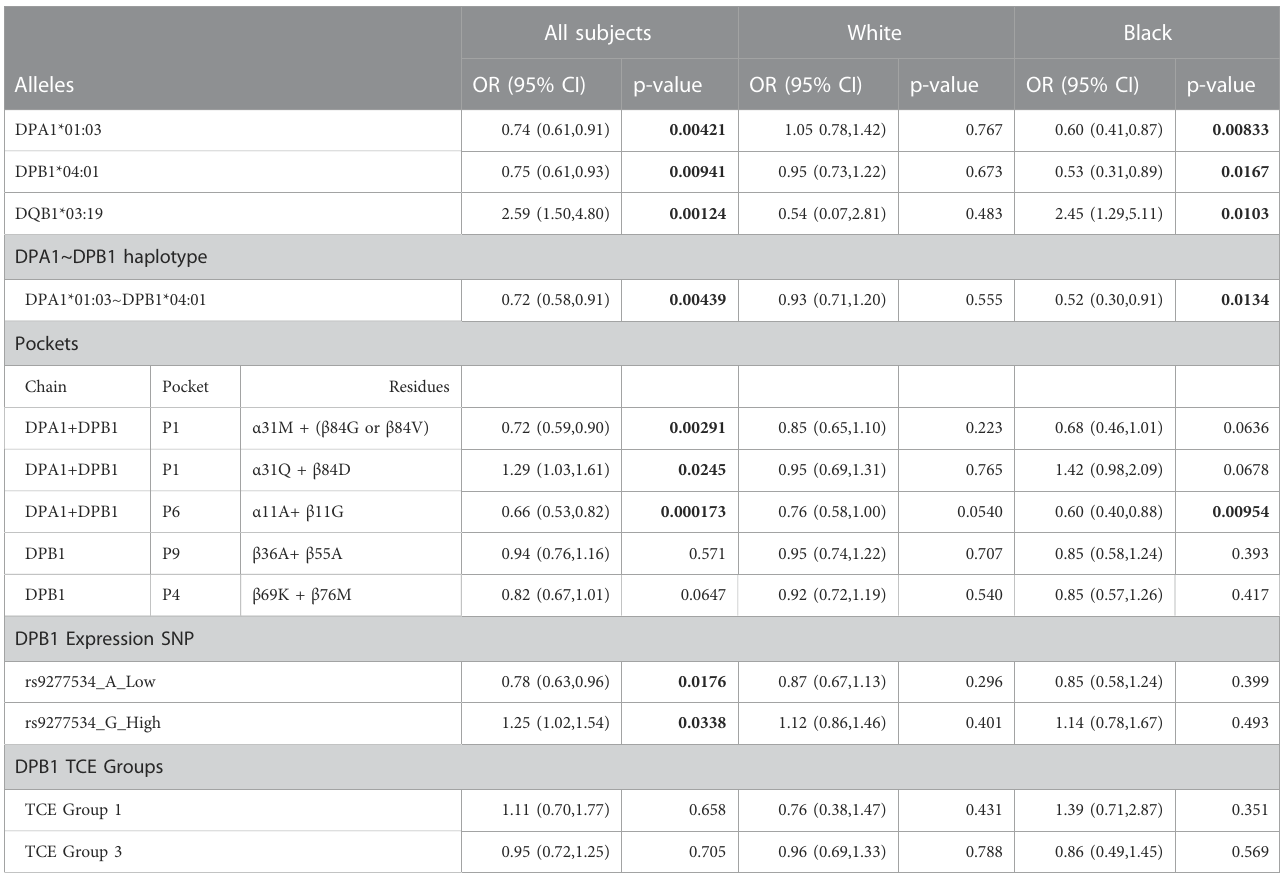
TABLE 9 Replication of GAD case fi ndings using PEER subjects for the signi fi cant associations found in the GAD cohort. Bold indicates signi fi cant p -value.